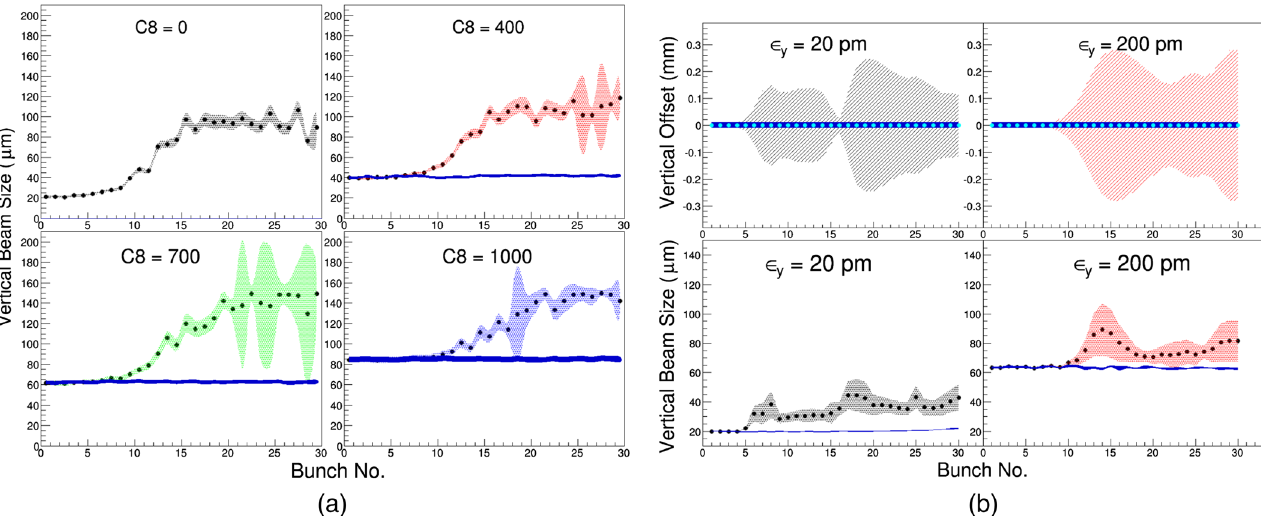
FIG. 13. (a) Vertical bunch size as a function of bunch number for different vertical emittances. (b) Simulated vertical bunch motion (top) and size (bottom) as a function of bunch number for different vertical emittances. (Lightly shaded ¼ RMS amplitude with vertical feedback off, filled ¼ feedback on, dots ¼ mean